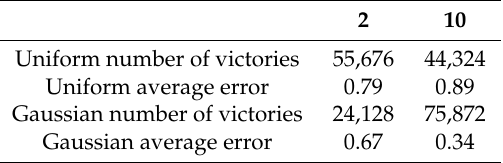
Table 9. k = 2 vs. 10 with rounding compression. For k = 10 only scores permitted between 3 and 6.